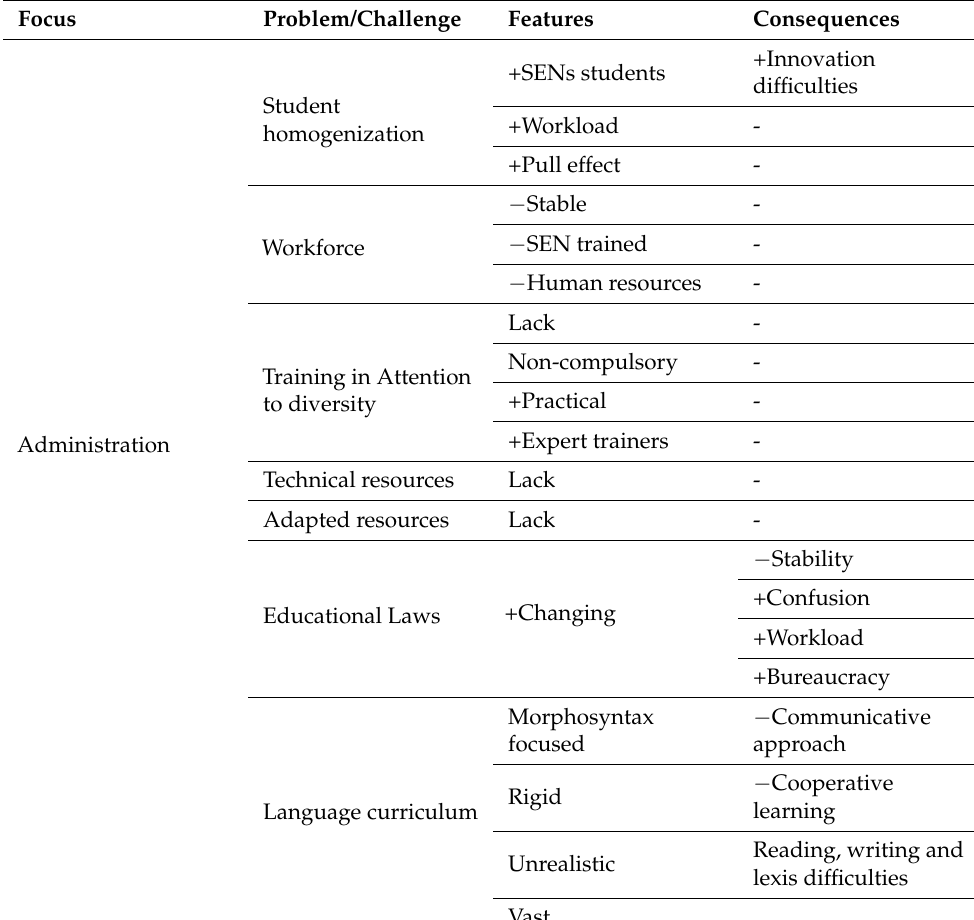
Table 4. Summary of stakeholders’ perceived problems/challenges in teaching an FL to a MID